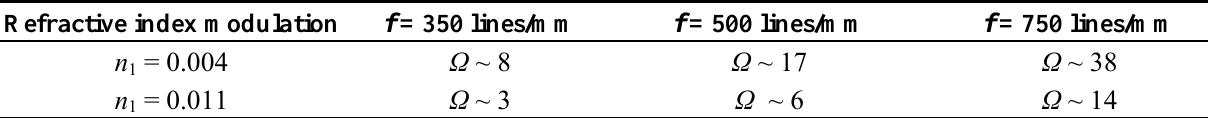
Table 1. Values of the parameters of the phase transmission gratings for different spatial frequencies.